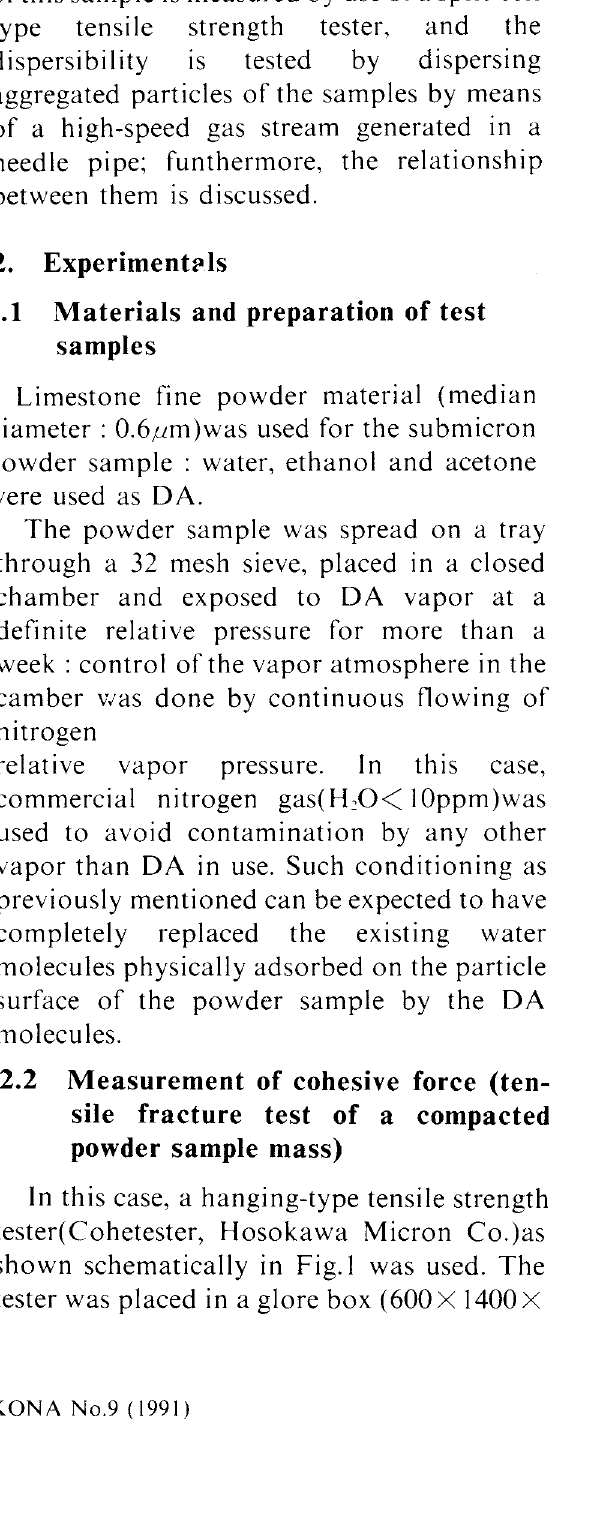
Fig. I Diagram of split cell type tensile strength tester